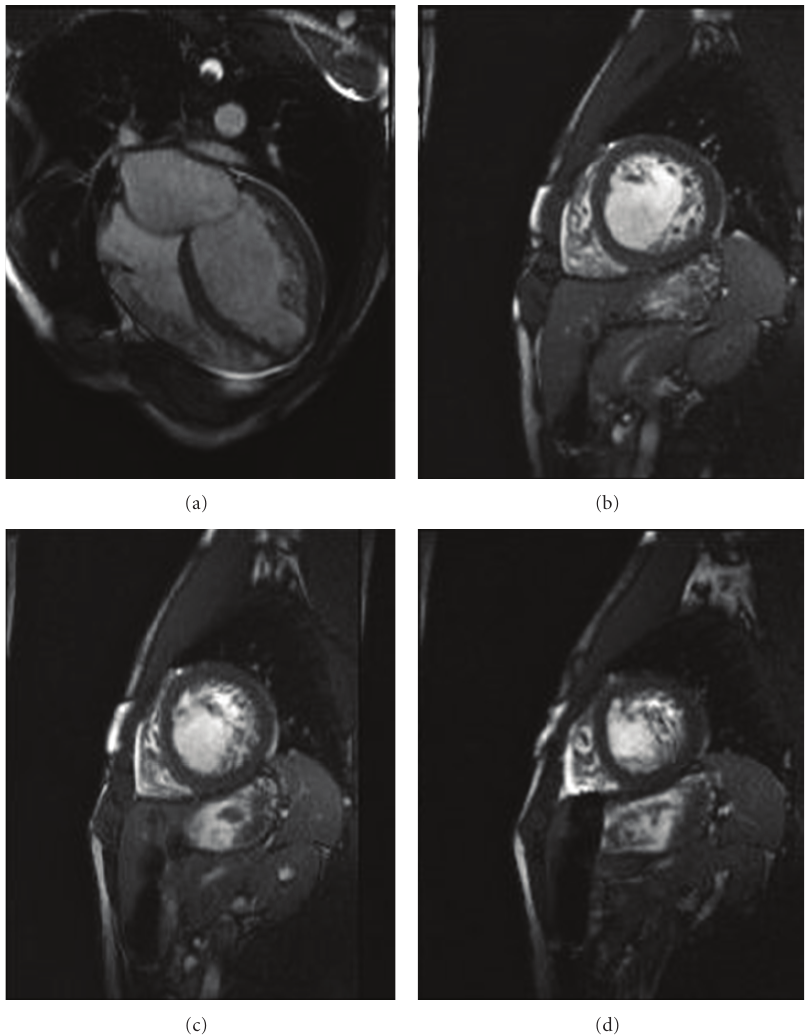
Figure 2: CMR images. Four chamber and short-axis views through the basal, mid-chamber, and apical segments in end diastole, demonstrating a 2-layered compacted and non-compacted myocardium. This is observed in the free wall of the left ventricle, particularly towards the apex although unusually the true apex is spared-. Di ff erentiation from the papillary muscles (not shown) is made on the basis that this structure did not communicate with the mitral valve on the long